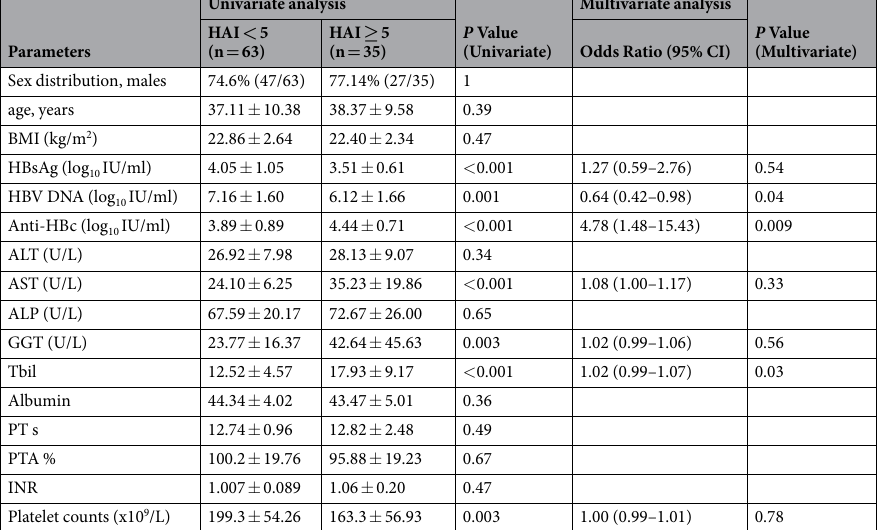
Table 3. Univariate and multivariate analysis of clinical parameters, cytokines with histological activity index in HBeAg ( + ) patients with normal ALT levels (n = 98). MBI, body mass index; HBsAg, hepatitis B surface antigen; HBeAg, hepatitis B e antigen; anti-HBc, hepatitis B core antibody; ALT, alanine aminotransferase; AST, aspartate aminotransferase; ALP, alkaline phosphatase; GGT, gamma-glutamyl transpeptidase; Tbil, total bilirubin; PT, prothrombin time; PTA, prothrombin time activity; INR, international normalized